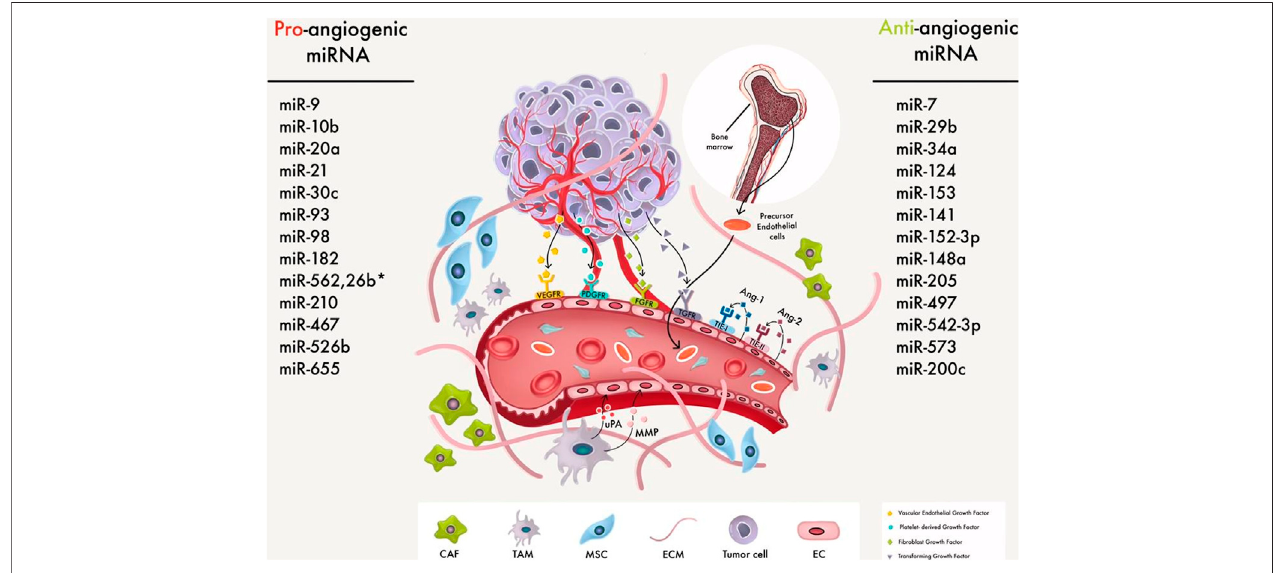
FIGURE 2 | MiRNAs that regulate angiogenesis in BC cells. An anti-angiogenic miRNA can either slow or promote angiogenesis by affecting the many growth pathways involved in cancer management. For example, angiogenesis is a critical stage in tumor metastasis that might aid tumor spread, and angiogenesis in breast cancer involves TME and cancer cells communication. So miRs regulate BC angiogenesis via macrophages, MSCs, ECM, and CAFs.